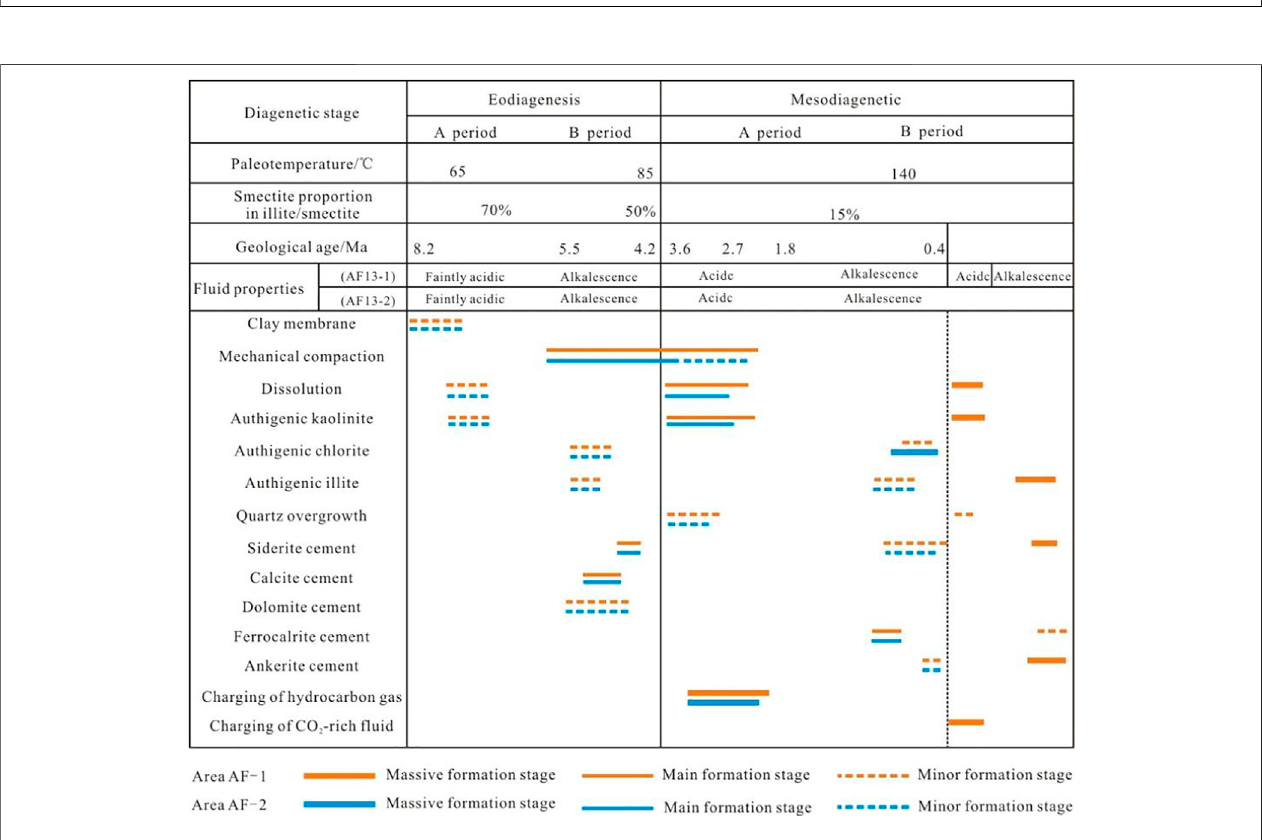
FIGURE 9 | Diagenetic sequence of the Huangliu sandstones in the AF-1 area and the AF-2 area.